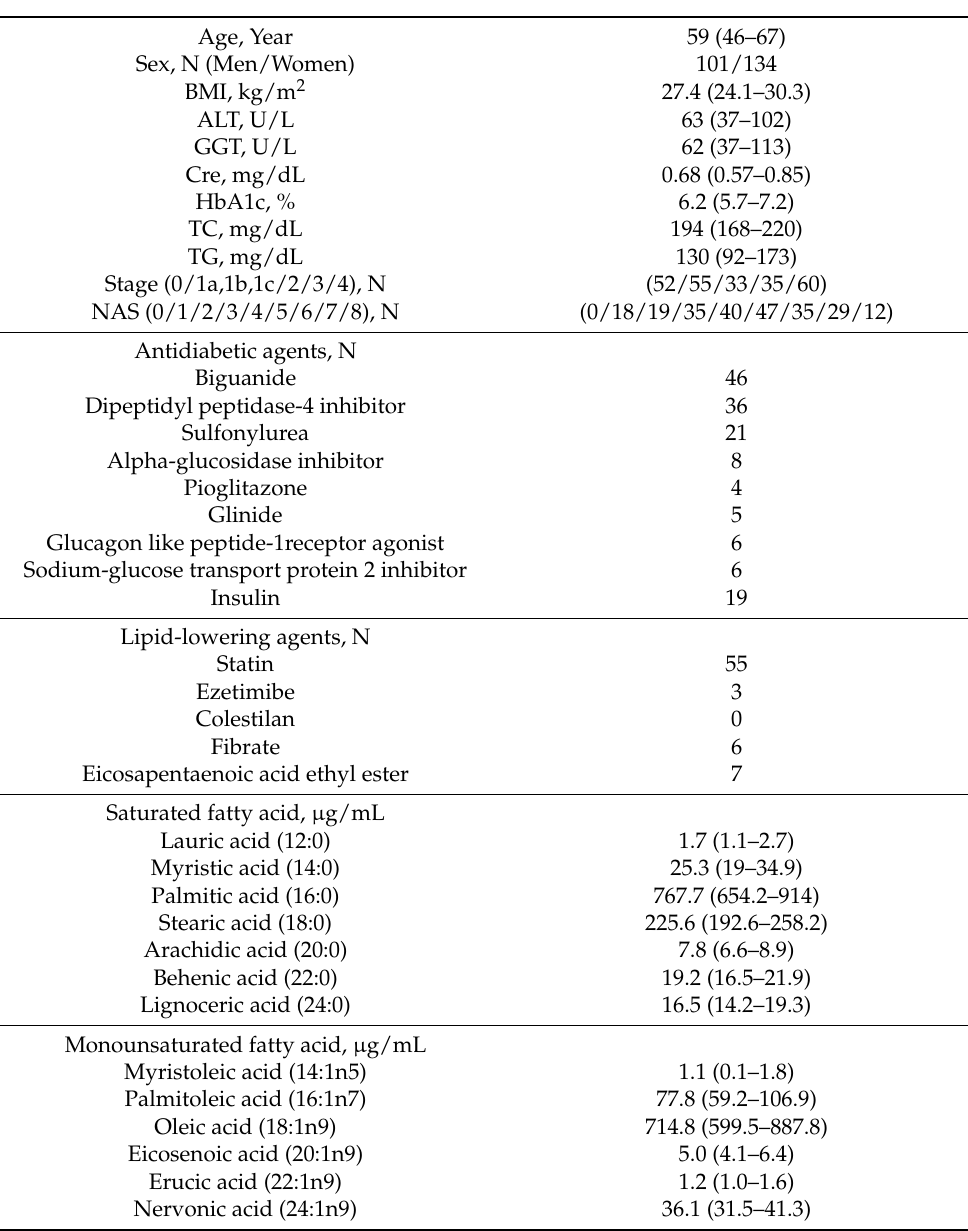
Table 1. Patients’